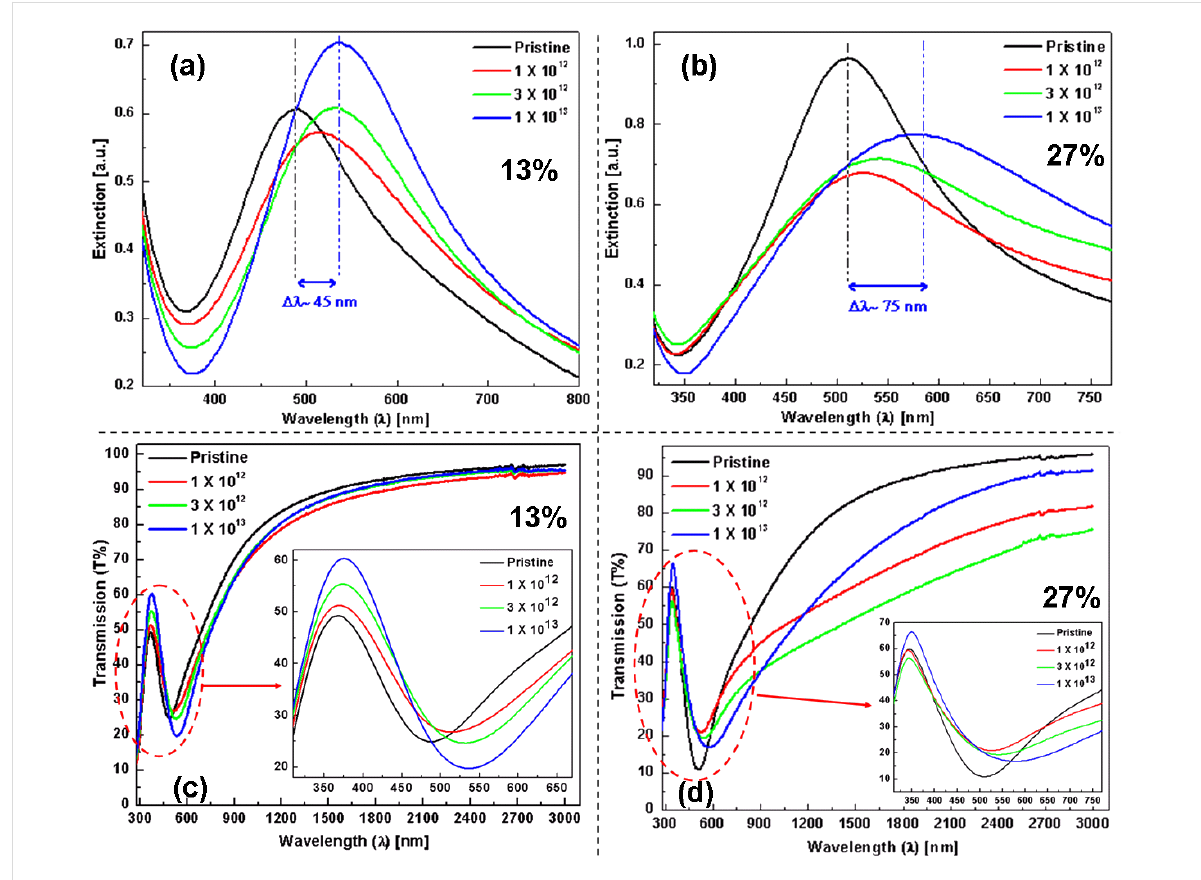
Figure 7: (a, b) UV–visible absorption spectra of Ag–TiO 2 nanocomposite films (MVF ca. 13% and 27%, respectively) as a function of the ion beam fluence (from 1 × 10 12 to 1 × 10 13 ions/cm 2 ). A red shift of the SPR peak of about 45 nm and 75 nm (for 13% and 27%, respectively) is observed after irradiation at the highest fluence. (c, d) Transmission spectra of Ag–TiO 2 nanocomposite films as a function of the ion beam fluence. Inset images (in c and d) are the magnified views corresponding to marked